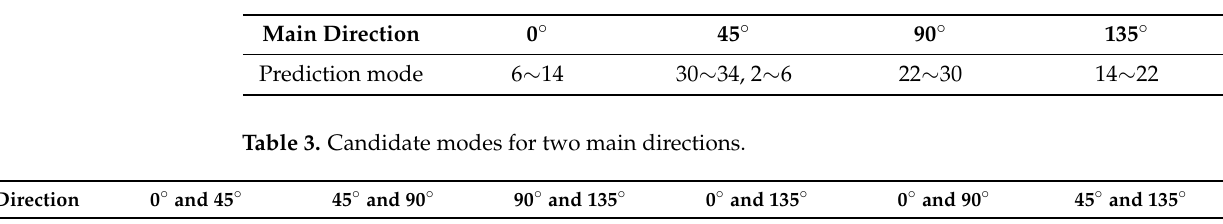
Table 2. Candidate modes for one main direction.